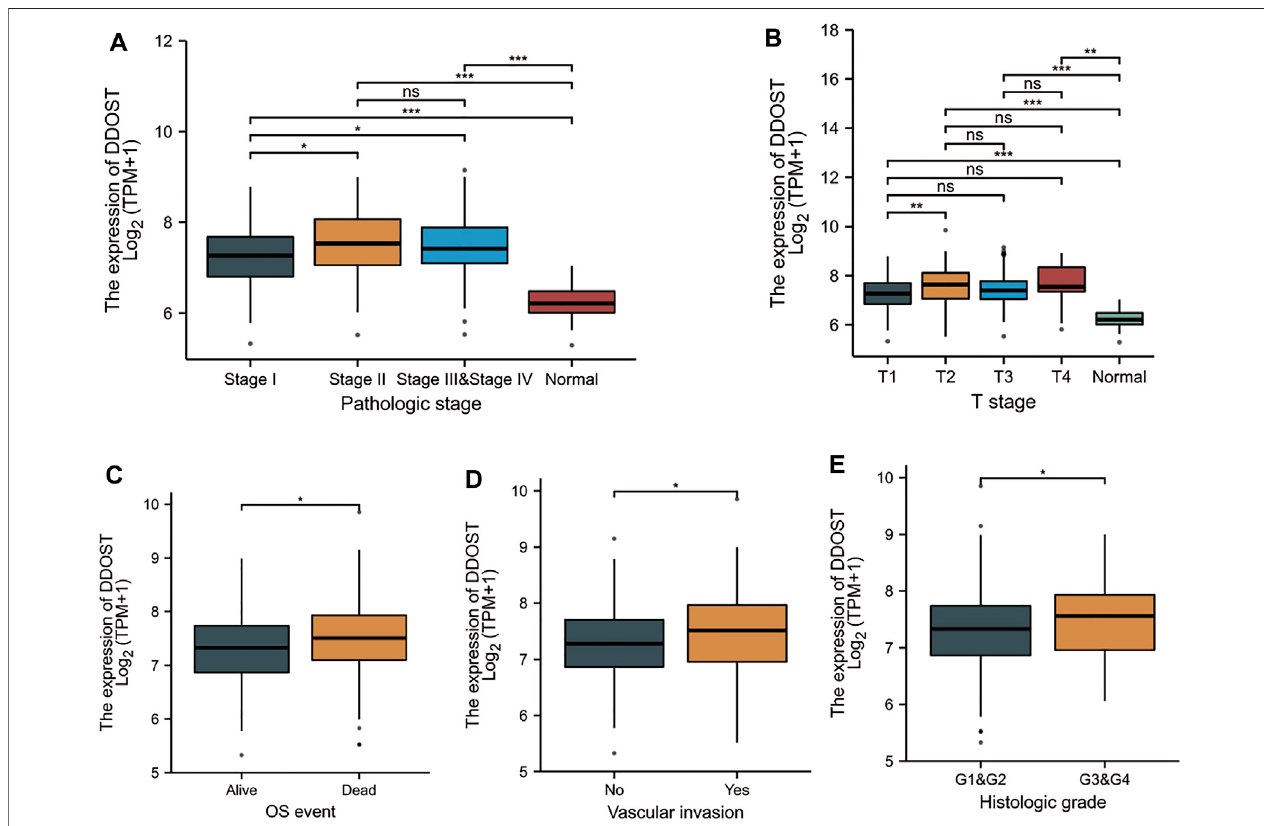
FIGURE 4 | Association between the DDOST expression and different clinicopathologic characteristics. (A) Association between the DDOST expression and the pathologic stage of HCC, (B) T stage, (C) OS event, (D) vascular invasion, and (E) histologic grade.